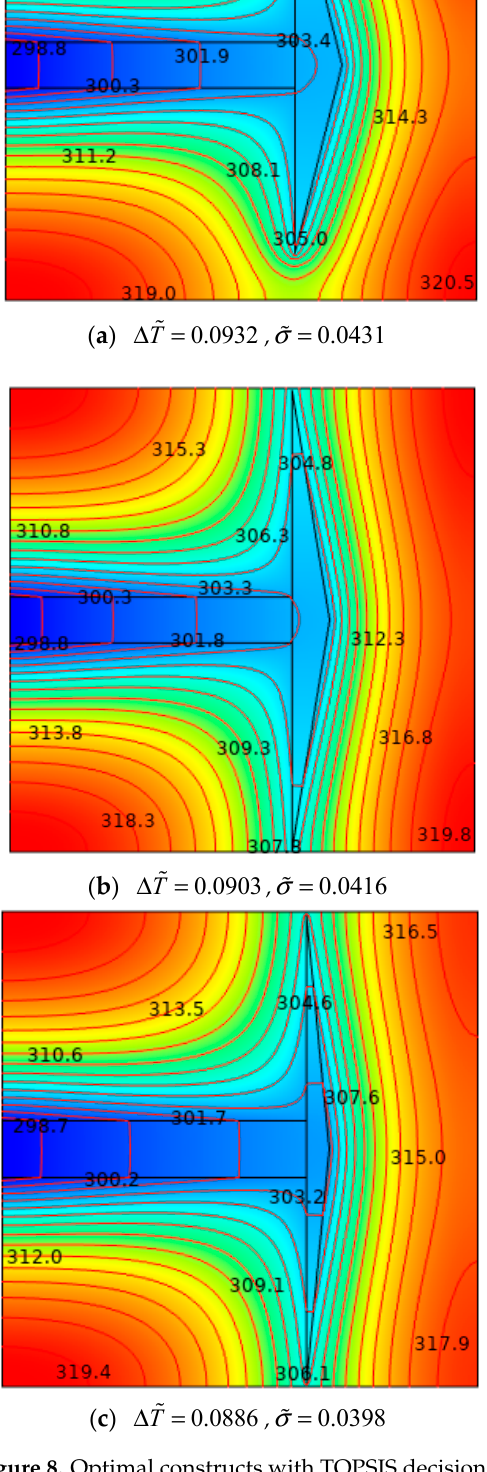
Figure 8. Optimal constructs with TOPSIS decision method based on ( a ) single-DOF optimization; ( b ) two-DOF optimization; ( c ) three-DOF optimization. (T emperature in K.)